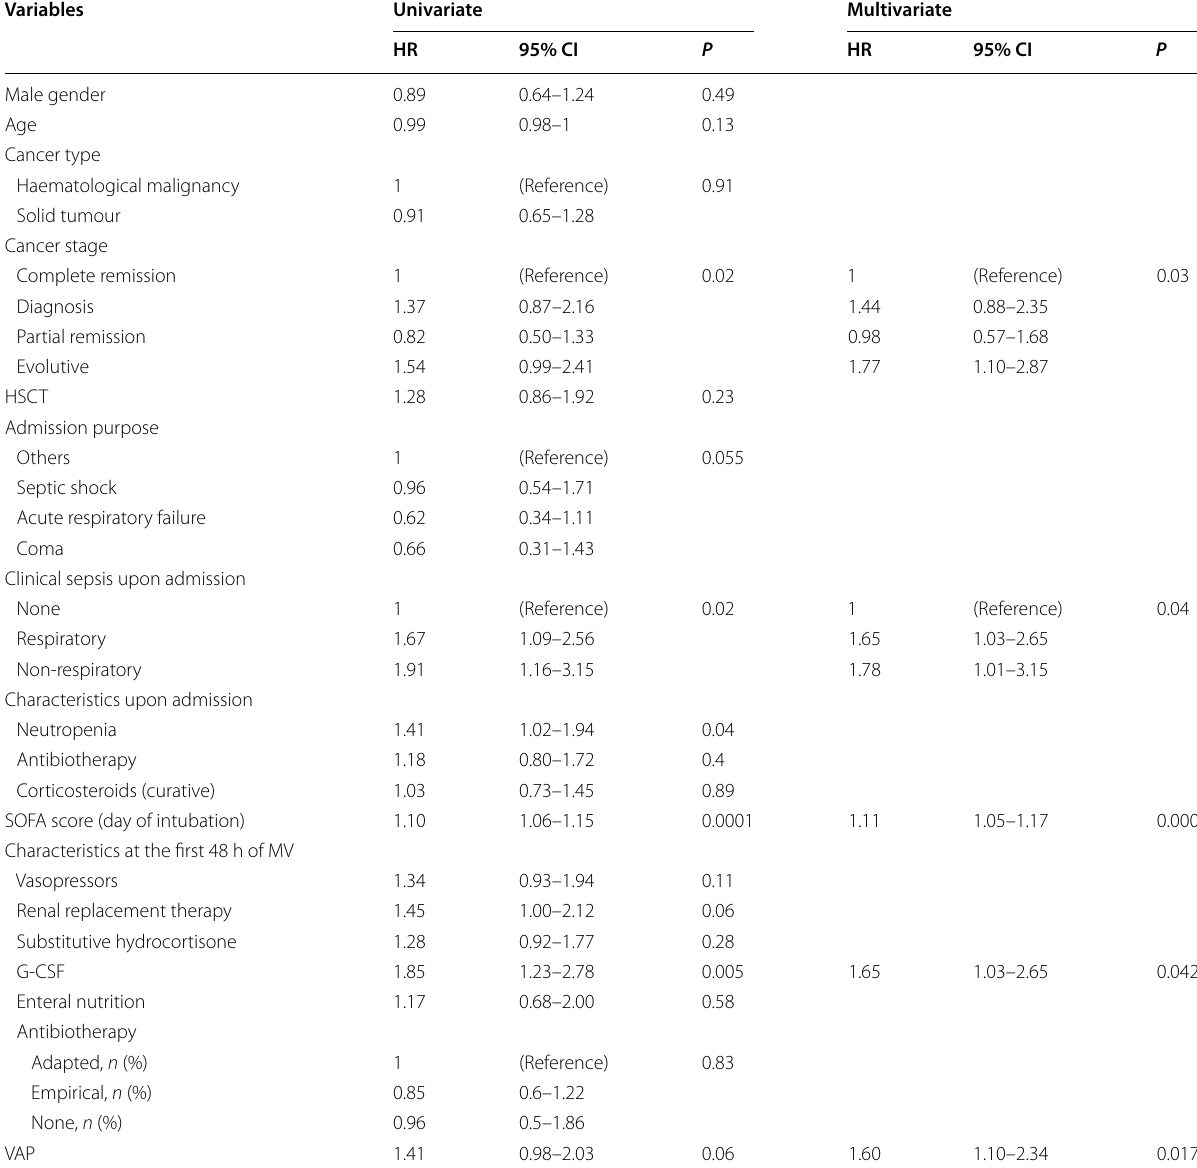
HSCT haematopoietic stem cell transplantation, G-CSF granulocyte colony-stimulating factors, MV mechanical ventilation, VAP ventilator-associated pneumonia